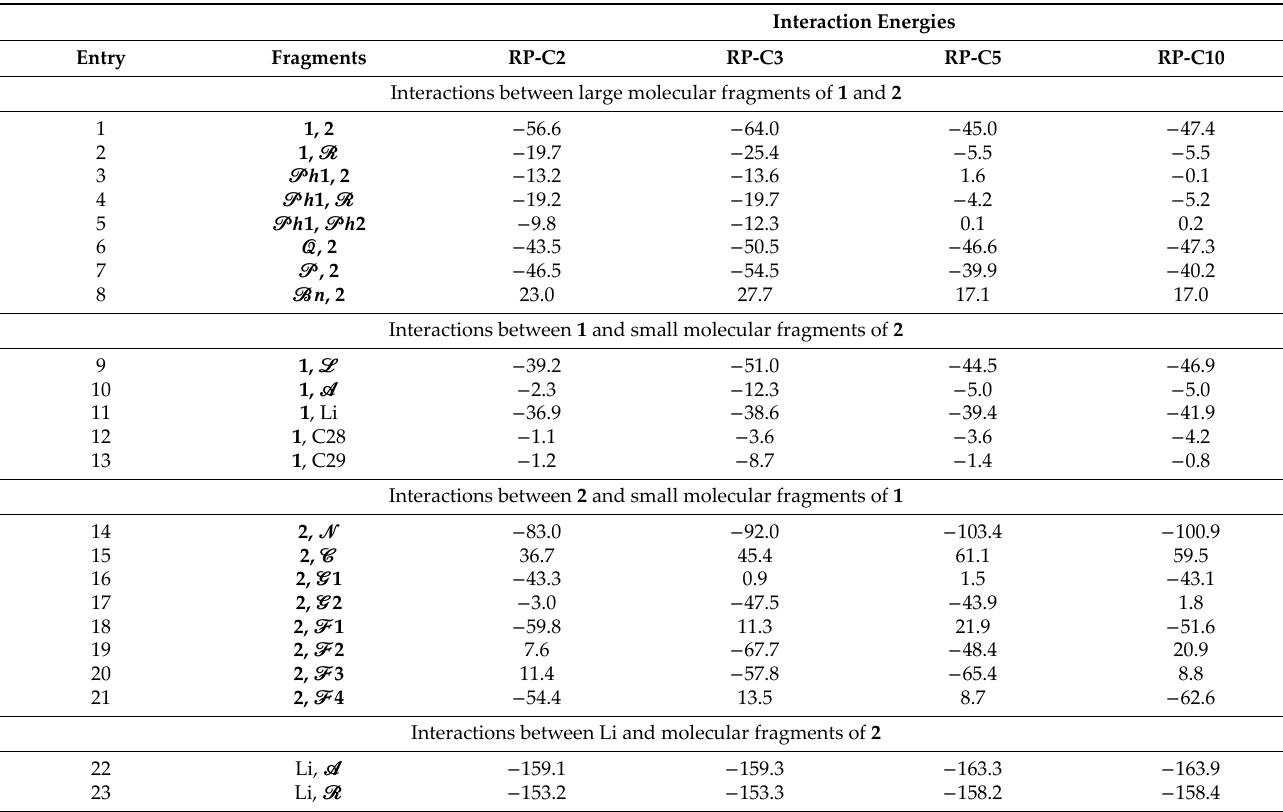
Table 2. Interaction energies between the indicated molecular fragments of adducts. Data (in kcal mol − 1 ) for all four potential RPs are